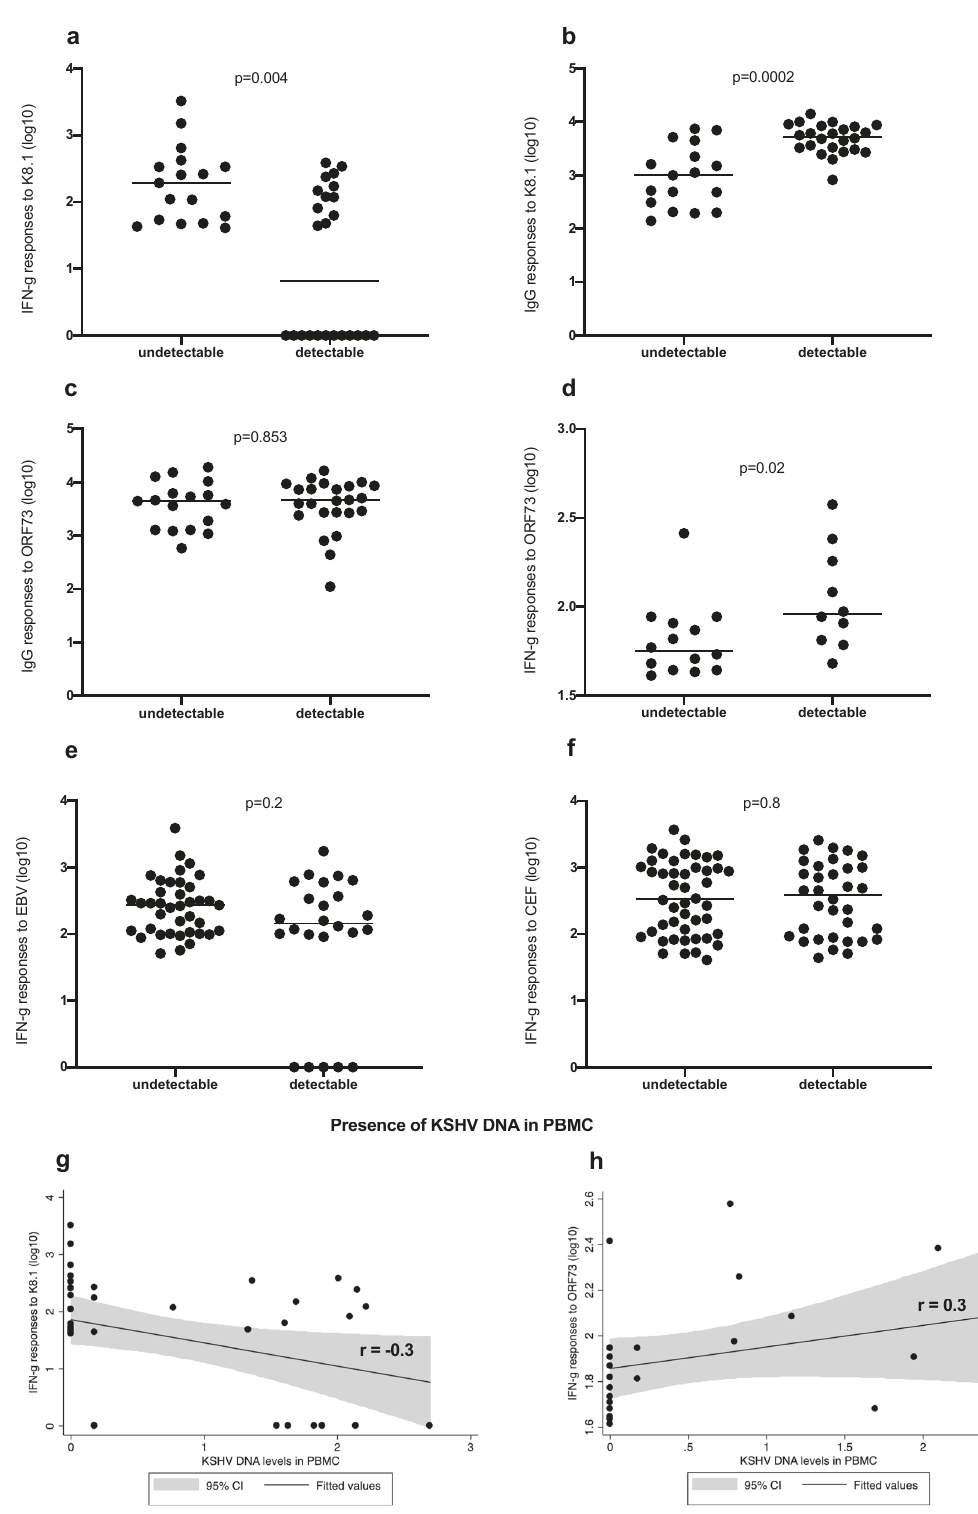
Fig. 5 Immune responses (IFN-y) and IgG antibody) to K8.1 and ORF73 as well as IFN-y responses to EBV and CMV + EBV + fl u cocktail-CEF in individuals with and without KSHV DNA in peripheral blood mononuclear cells (PBMC). a , g IFN-y responses to K8.1; b IgG antibody responses to K8.1; c IgG antibody responses to ORF73; d , h IFN-y responses to ORF73; e IFN-y responses to EBV; f IFN-y responses to